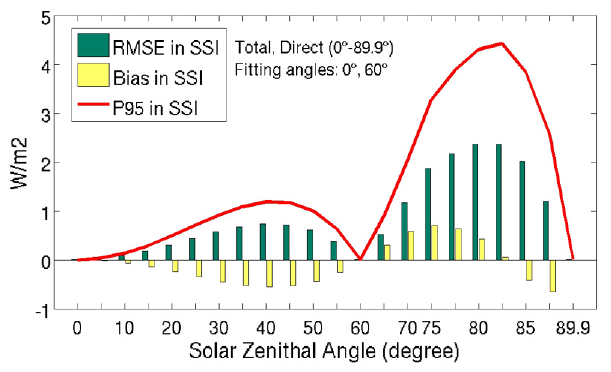
Figure 2. Errors in direct total SSI (0 ◦ , 60 ◦ ). Figure 3. Errors for global total SSI (piecewise MLB).